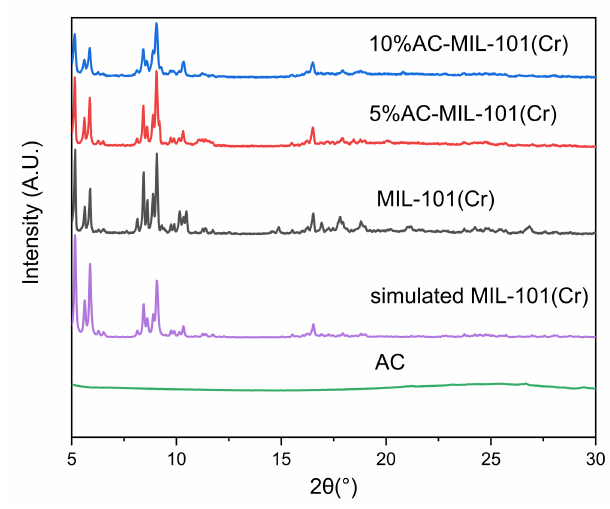
Figure 2. XRD pattern.